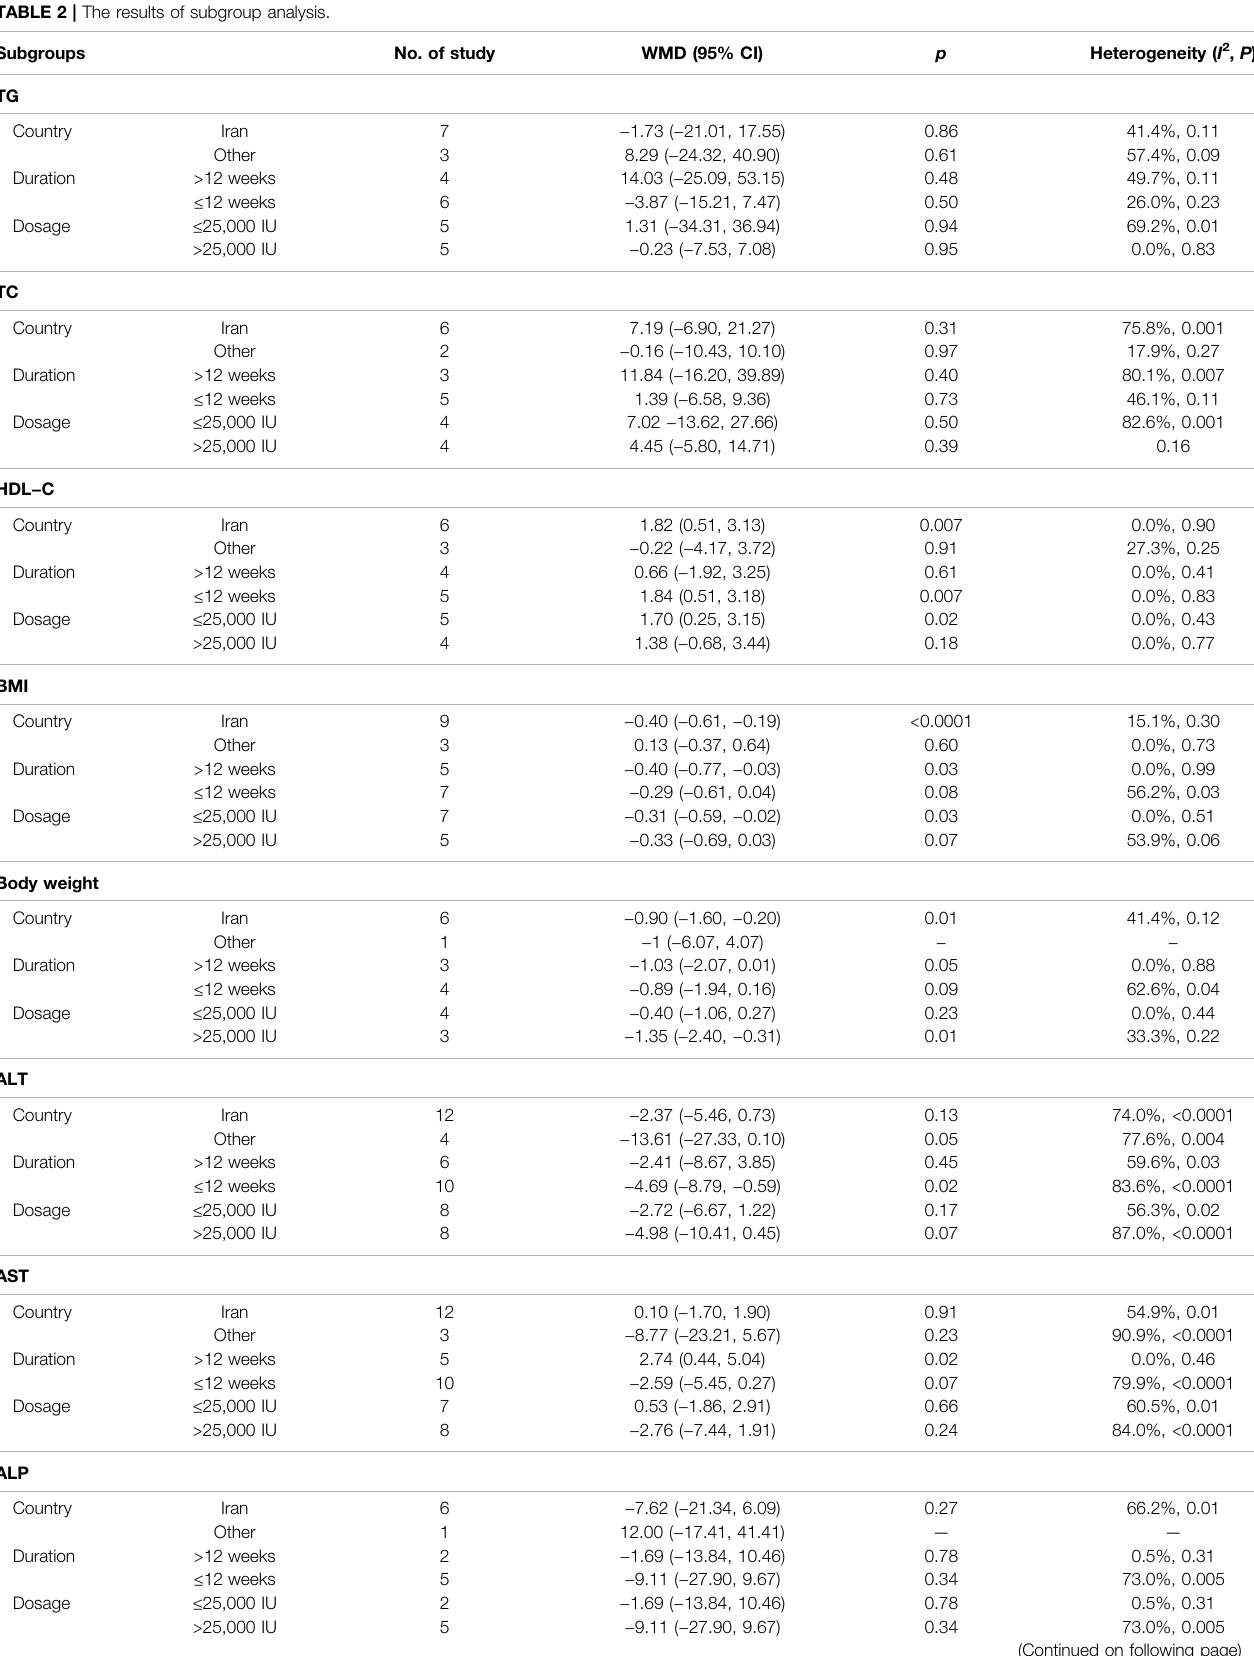
TABLE 2 | The results of subgroup